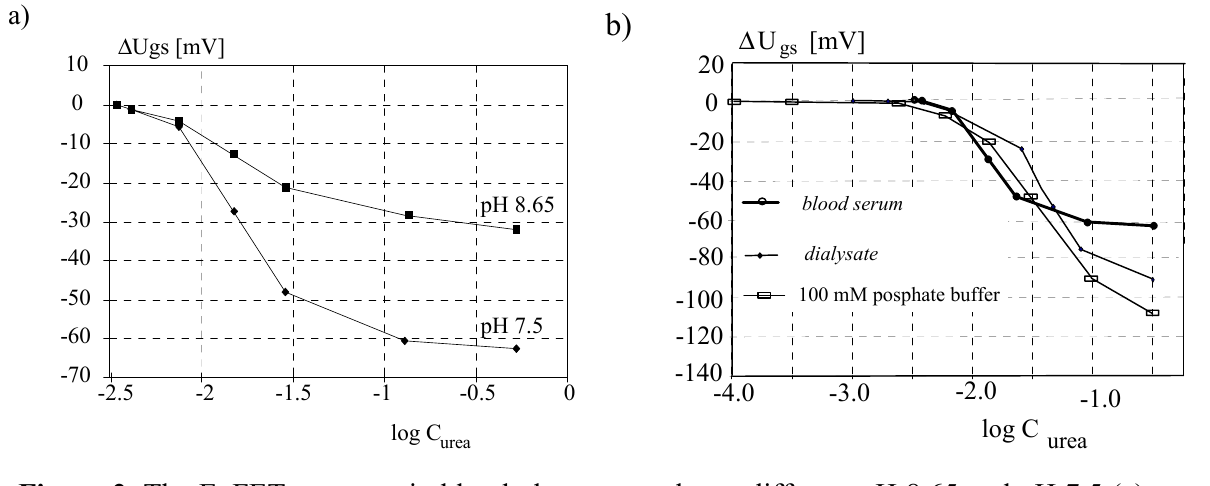
Figure 2. The EnFET response in blood plasma samples at different pH 8.65 and pH 7.5 (a), and in ortophosphate buffer solution of 100 mM concentration, blood plasma and dialysate (a concentrate of hemodialysis fluid D-605, diluted in the ratio 1:35)